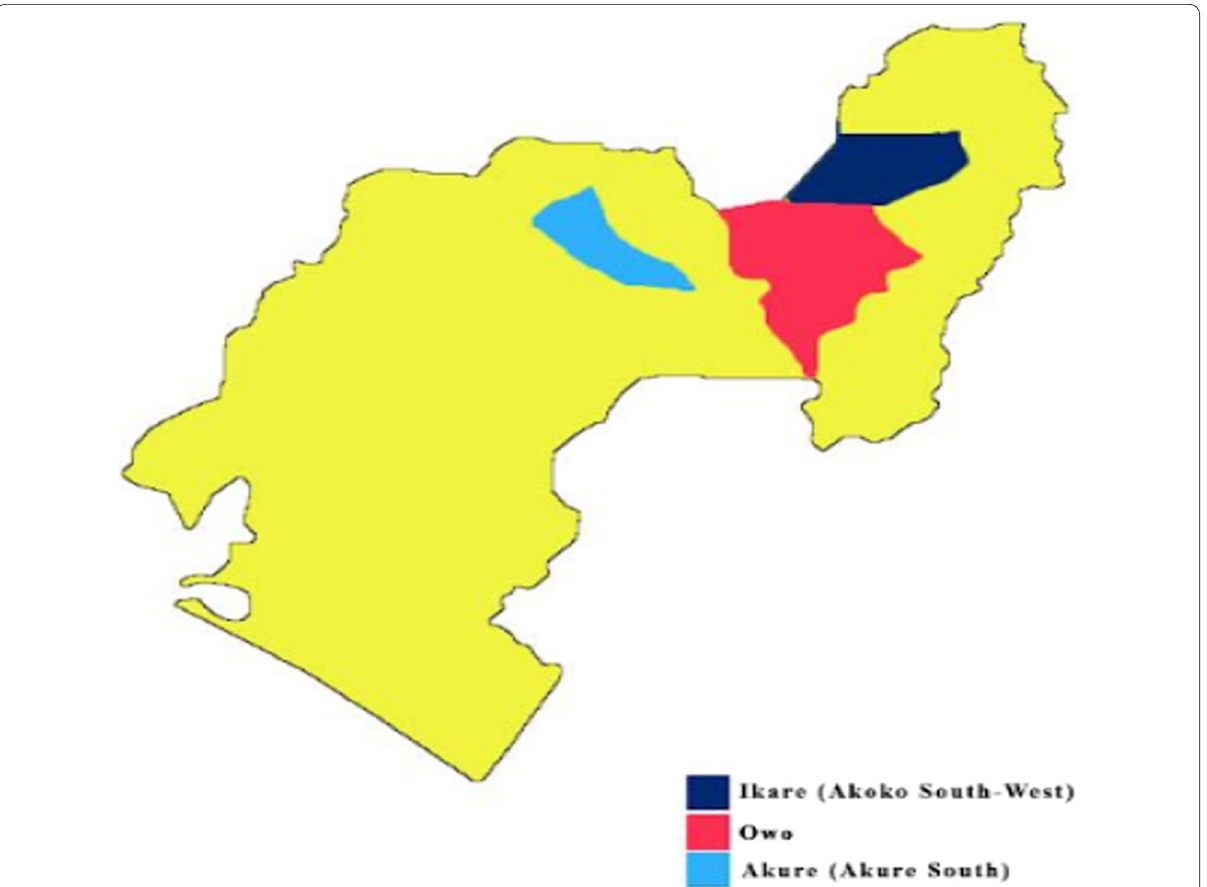
Fig. 1 Metropolitan locality map of Ondo State showing painted study areas of soft cheese